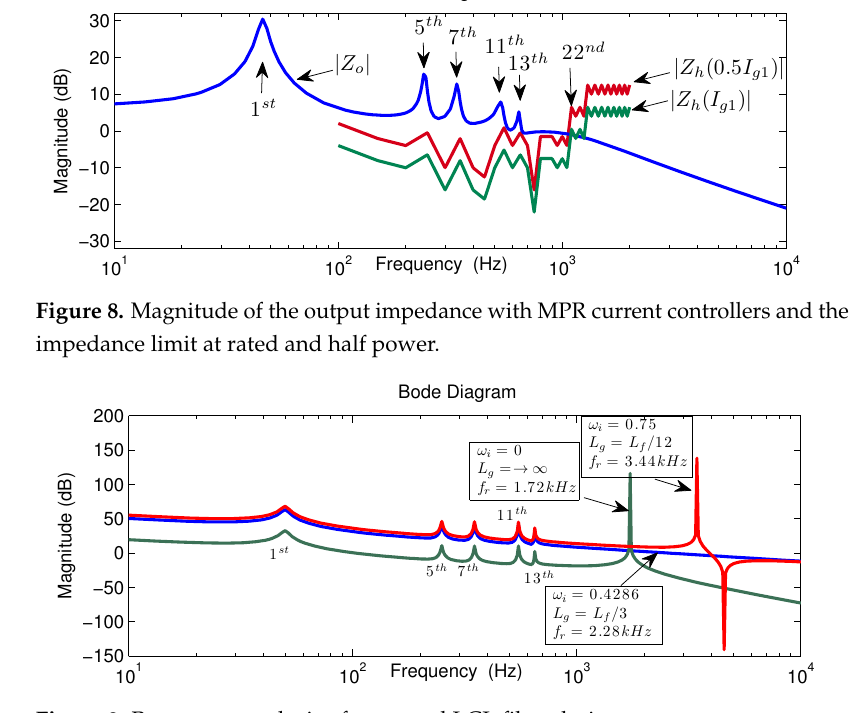
Figure 9. Resonance analysis of proposed LCL filter design.